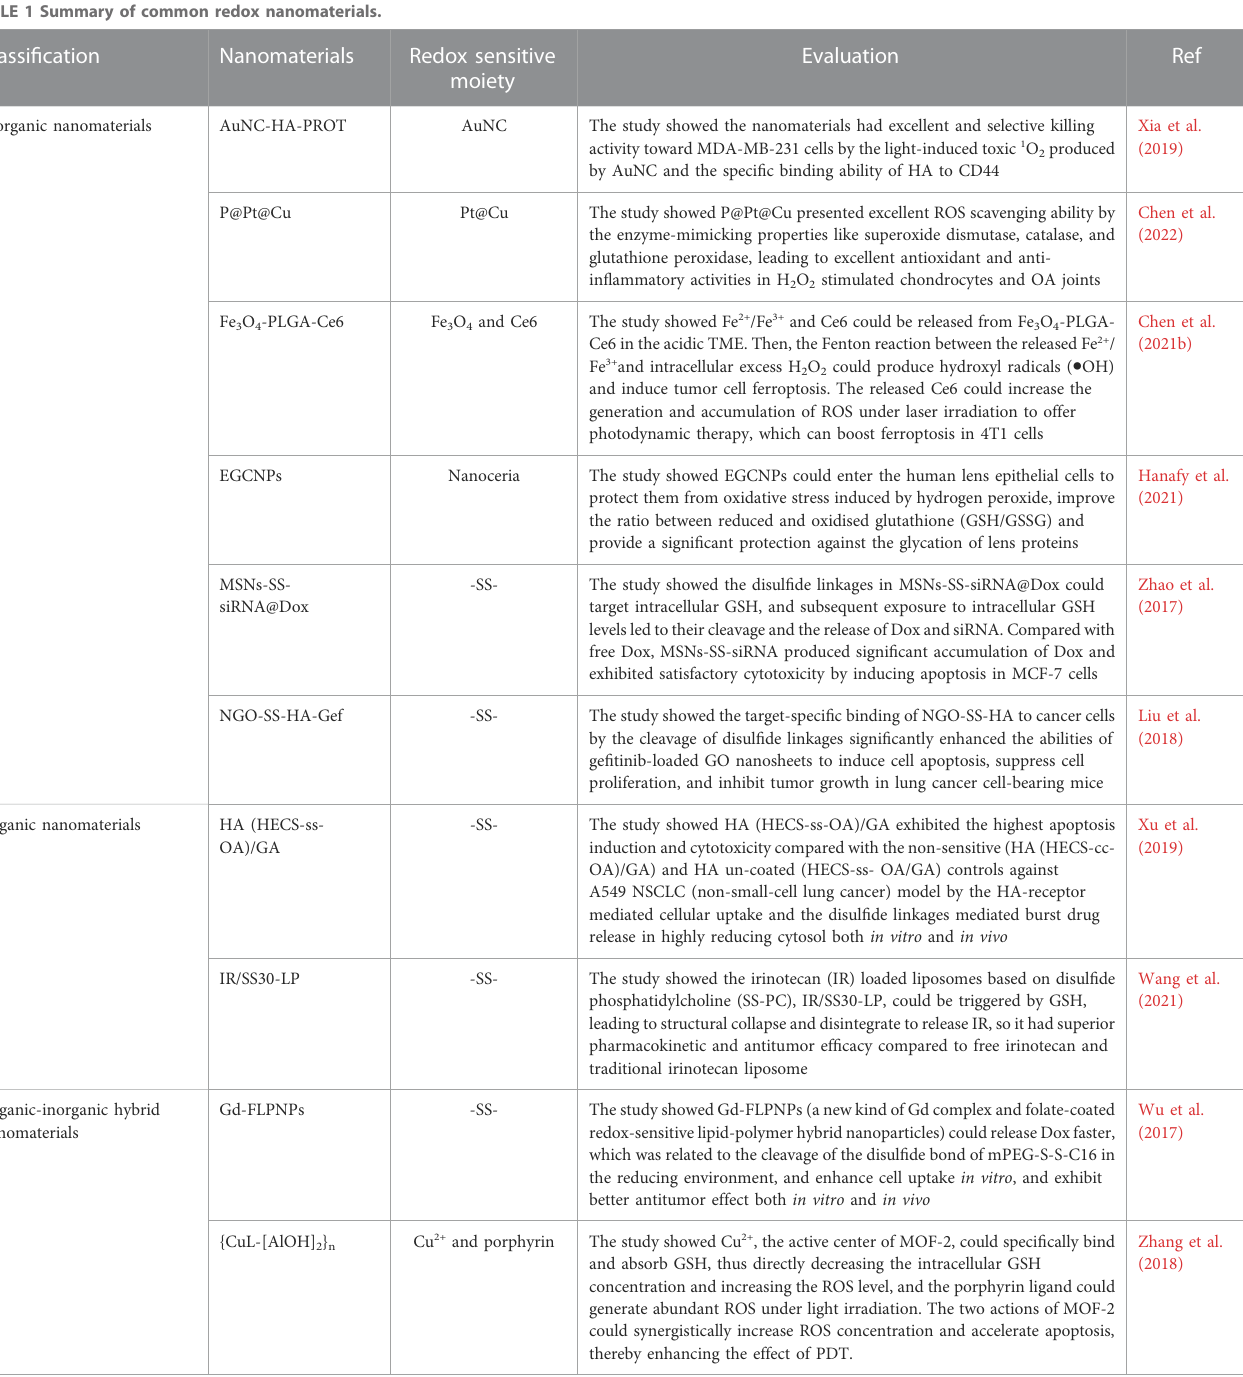
TABLE 1 Summary of common redox